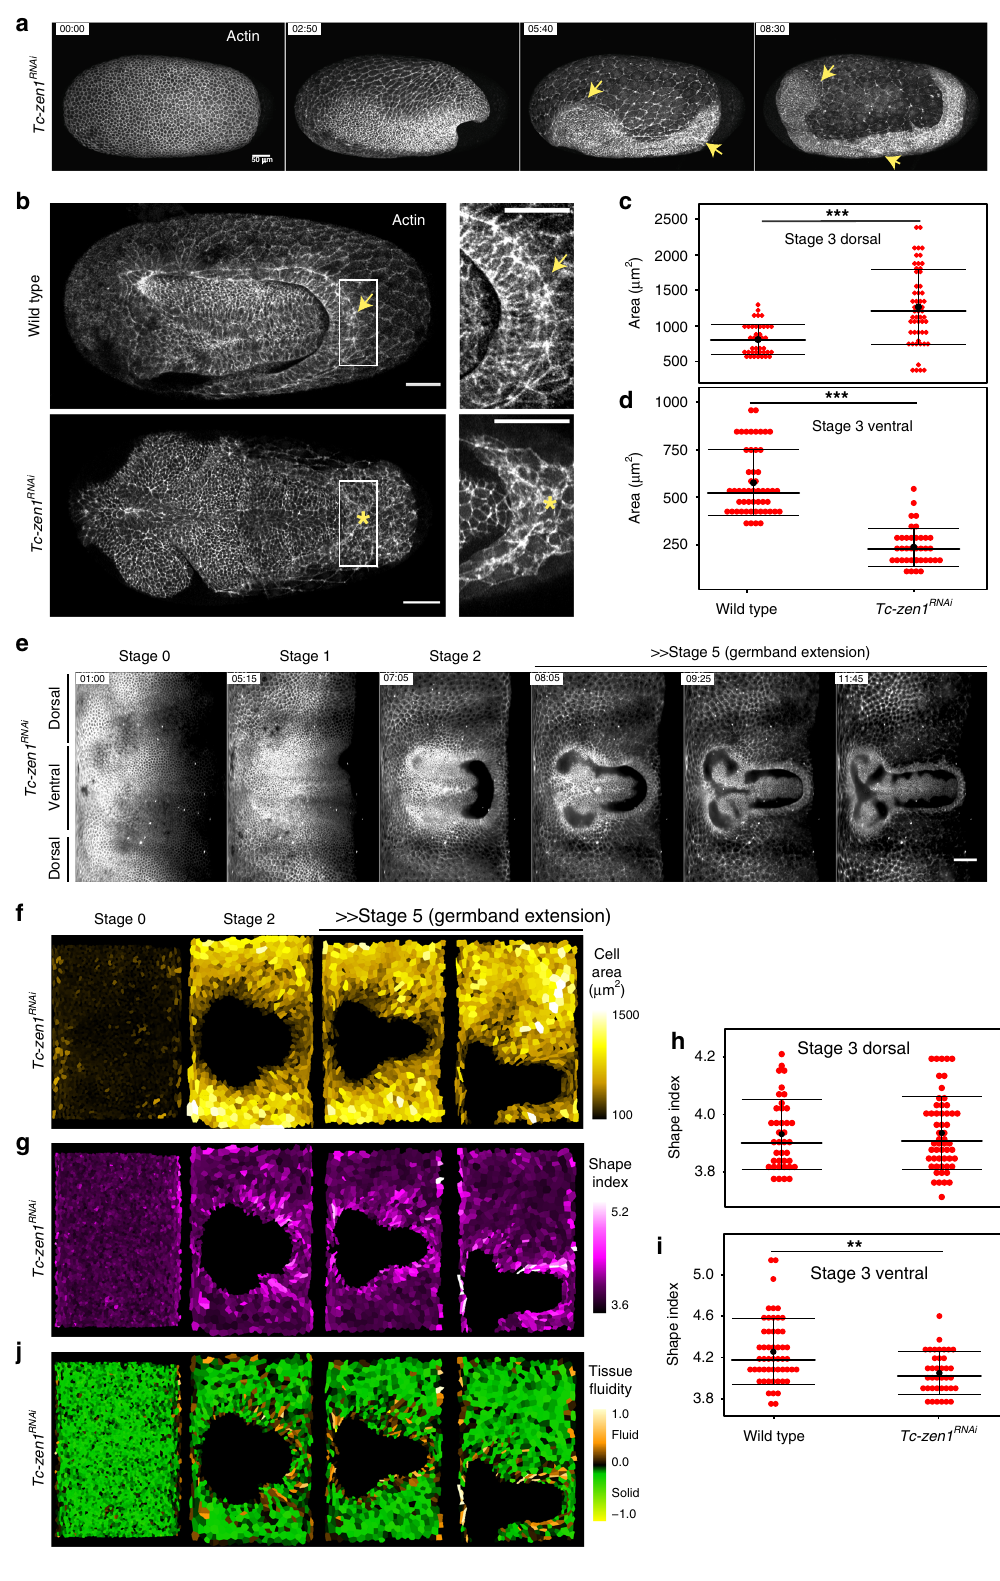
Laser ablations . Laser ablations were performed either on an inverted Zeiss LSM 780 NLO with a ×40/1.2 NA water-dipping objective using an 800 nm pulsed infrared laser or on a customized spinning disc confocal unit with a ×63 water- dipping objective using an ultraviolet laser microdissection apparatus similar to the one described in Grill et al. 47 . On the fi rst system, three planes with 1 – 2µm z - spacing were imaged every 1.6s (Fig. 4f), 2.5s (Fig. 4g), or 2.6s (Fig. 3c) and the